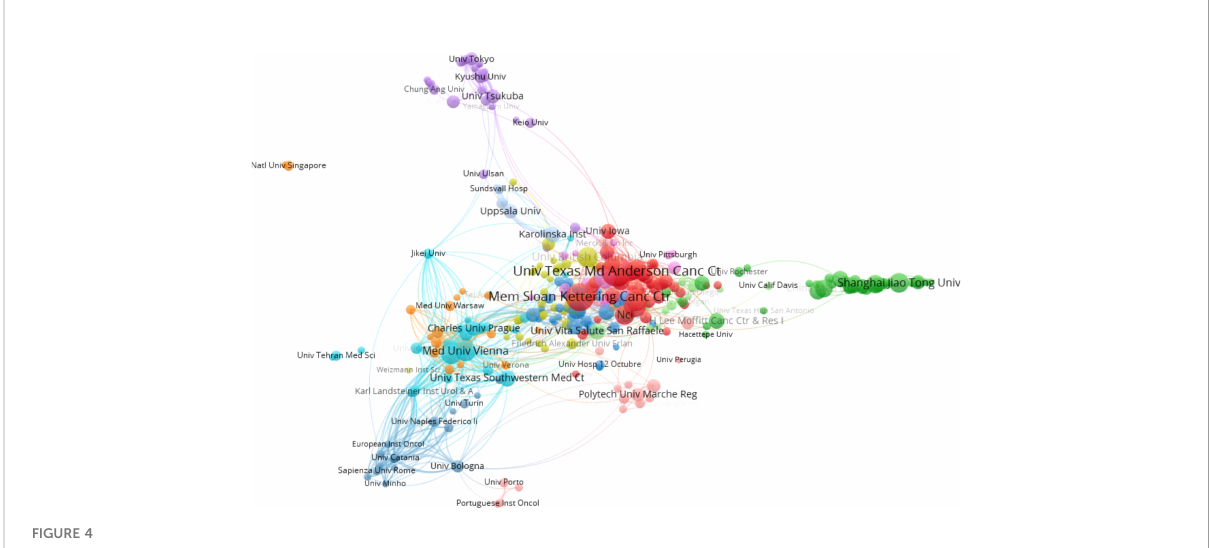
FIGURE 4 The network map of cooperation between af fi